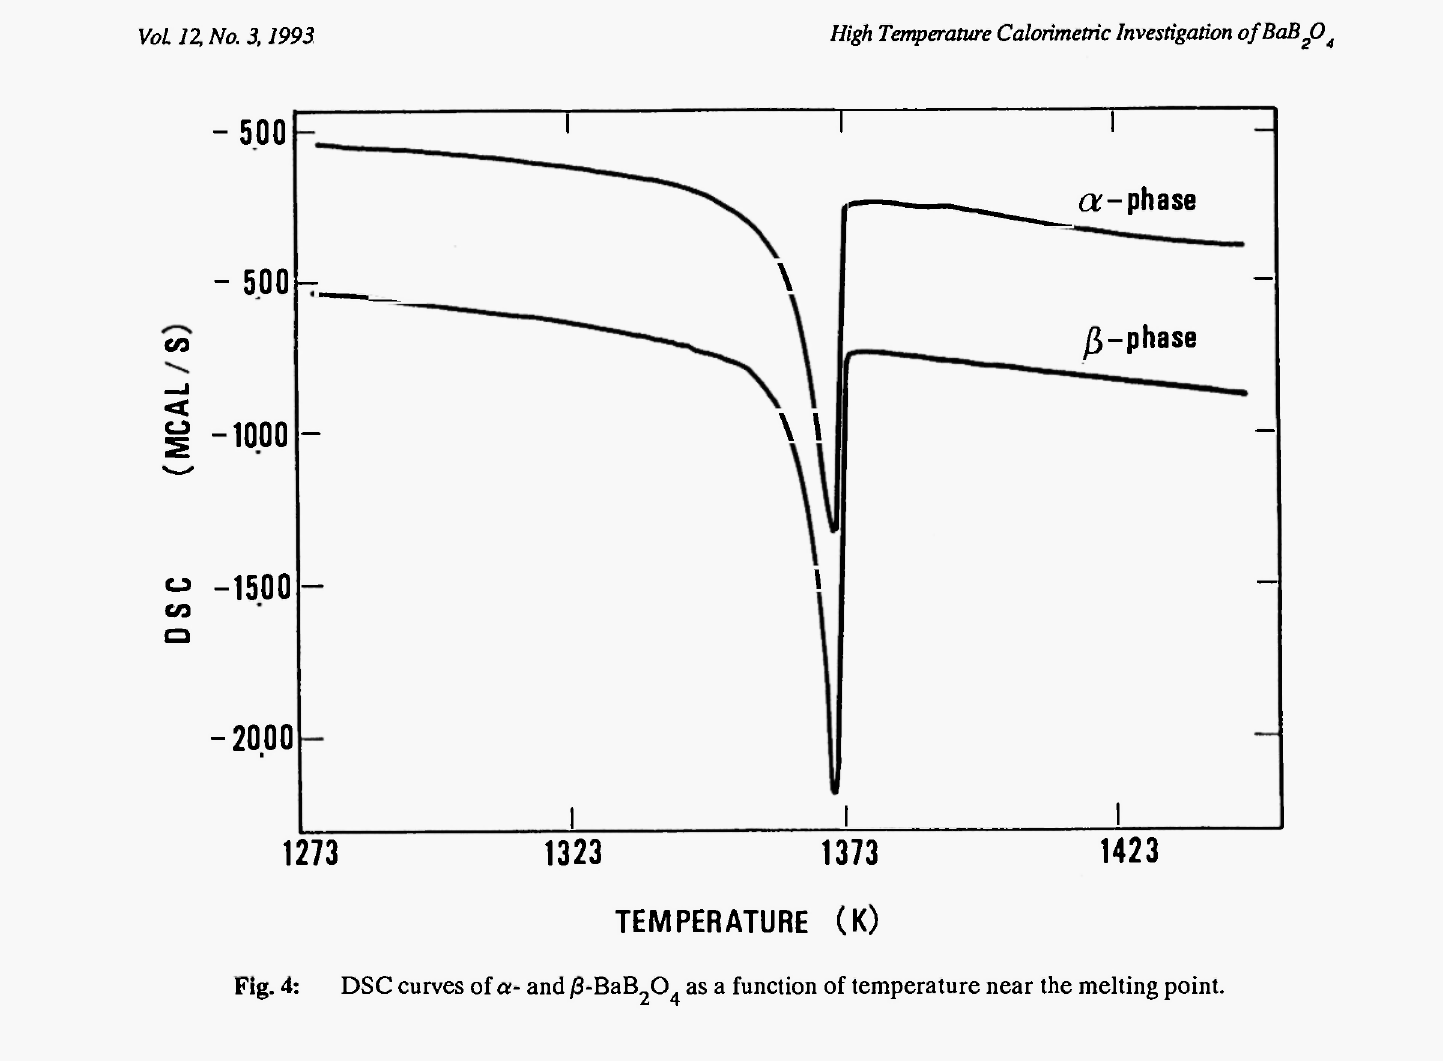
DSC curves of a- and /3-BaB 2 C> 4 as a function of temperature near the melting point.